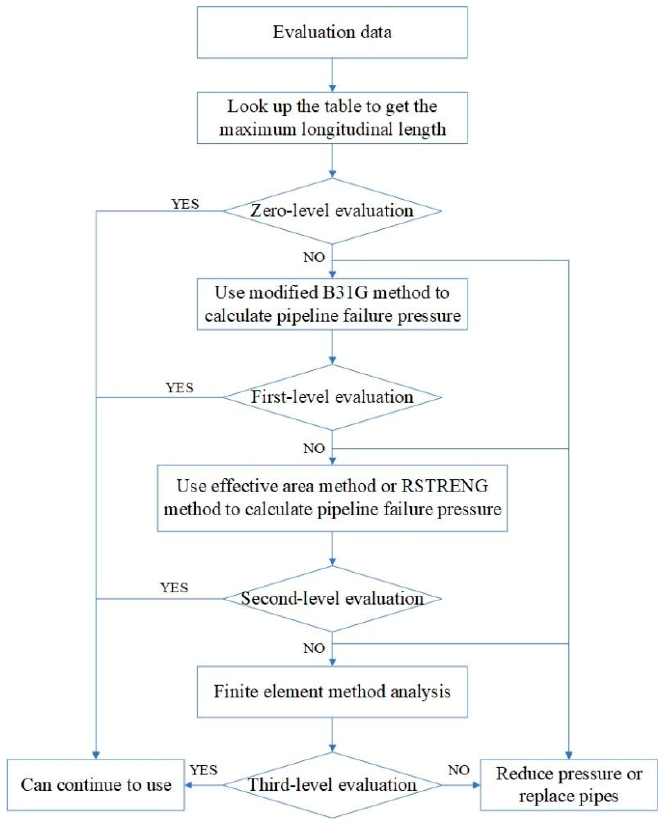
Figure 2. The evaluation process of ASME B31G-2009.